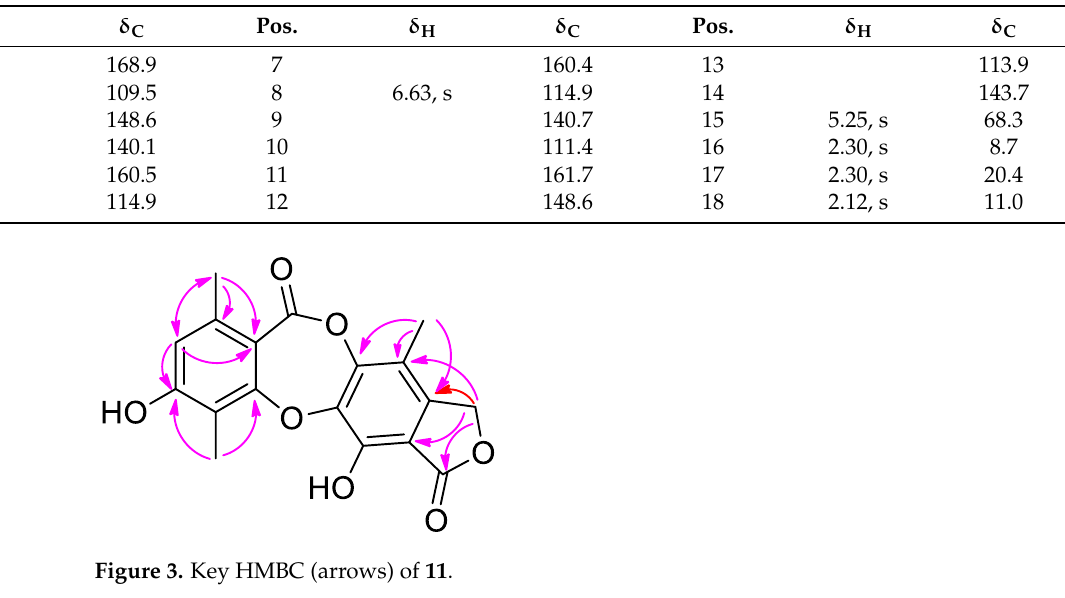
Figure 2. Key HMBC (arrows), 1 H- 1 H COSY (bonds), and NOE (double arrows) correlations of 1 . Table 2. 1 H (500 MHz) and 13 C NMR (125 MHz) spectroscopic data for 11 in DMSO- d 6 .